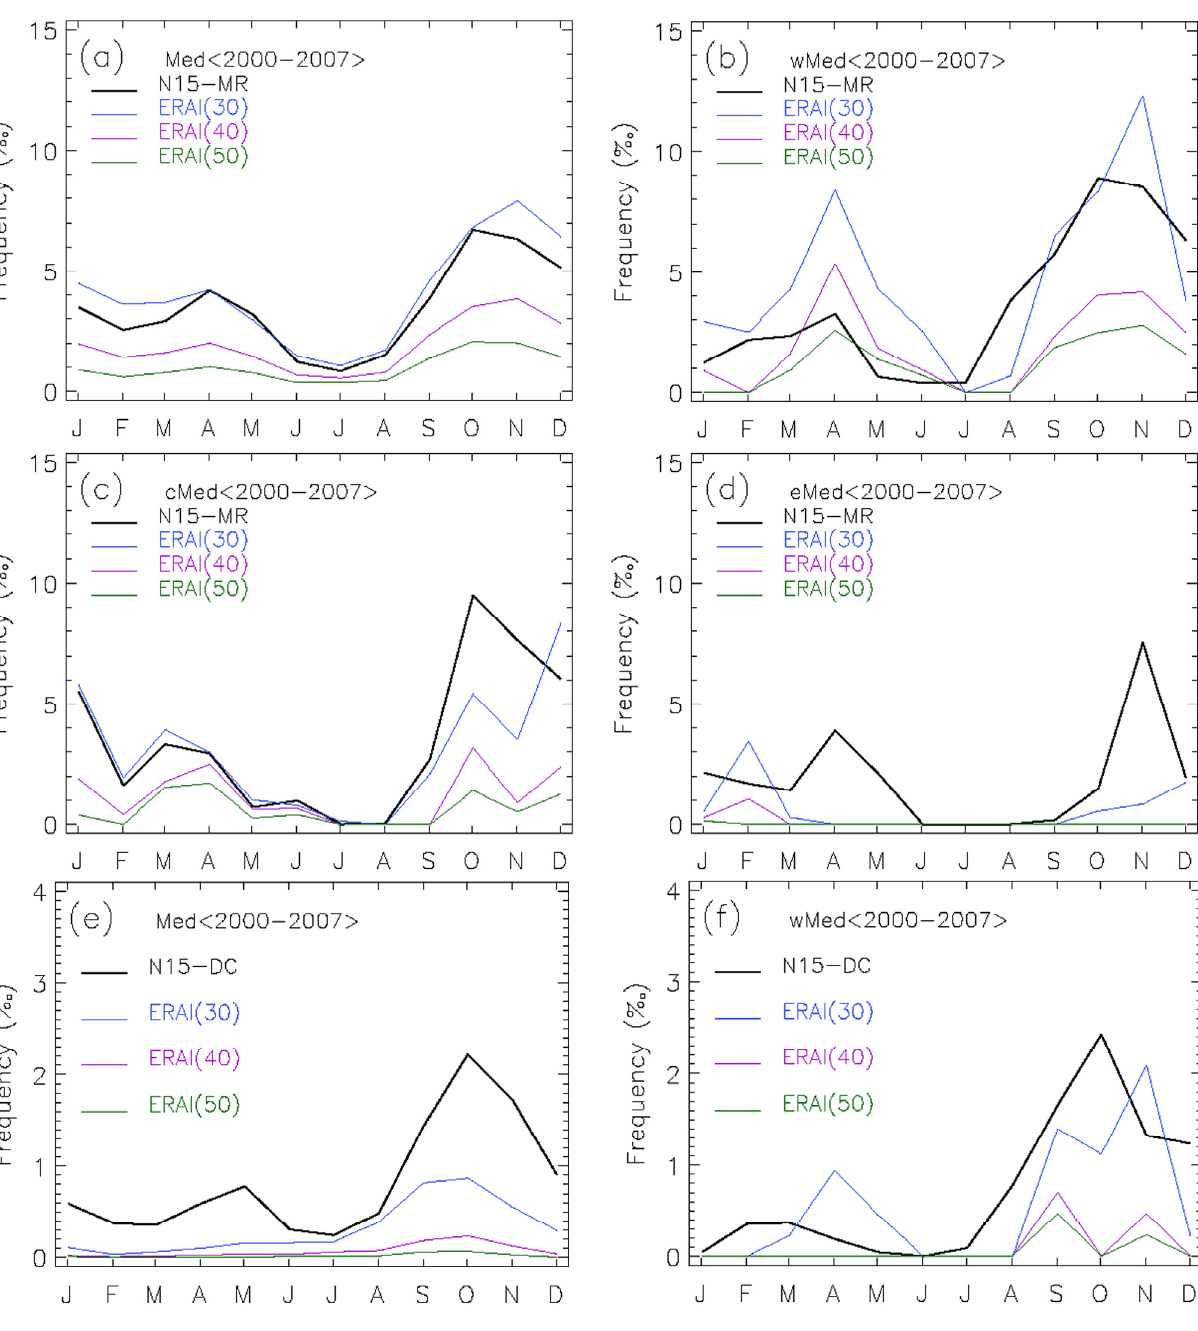
Figure 11. Monthly mean annual cycle averaged over the period 2000–2007 in ( a ) Mediterranean sea (Med), ( b ) wMed, ( c ) cMed and ( d ) eMed of NOAA-15 MR frequency (thick-solid black), and ERA-Interim reanalysis rain frequency (thin-solid) for different thresholds (30, 40 and 50 mm/day; blue, purple, and green respectively) and in ( e ) Mediterranean sea (Med), ( f ) wMed, ( g ) cMed and ( h ) eMed of NOAA-15 DC frequency (thick-solid black), and ERA-Interim reanalysis DC frequency (thin-solid) for different thresholds (30, 40 and 50 mm/day; blue, purple, and green respectively). See Figure 8 for the regions